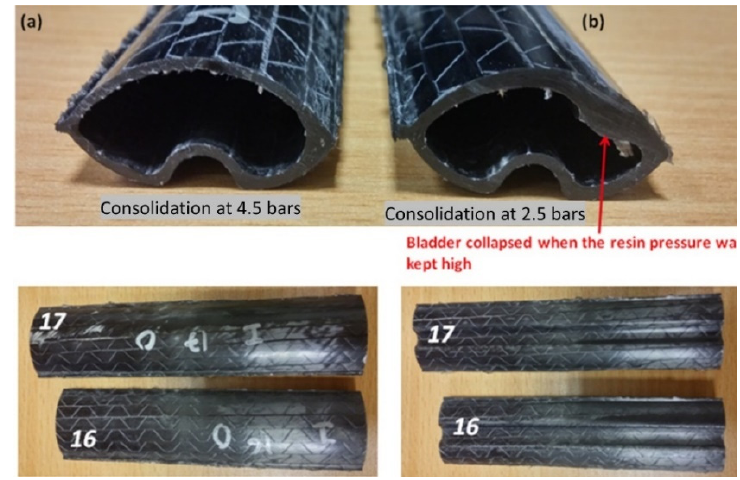
Figure 14. Effect of consolidation pressure on tubular sections manufactured using B-RTM process ( a ) consolidation at 4.5 bar ( b ) consolidation at 2.5 bar.